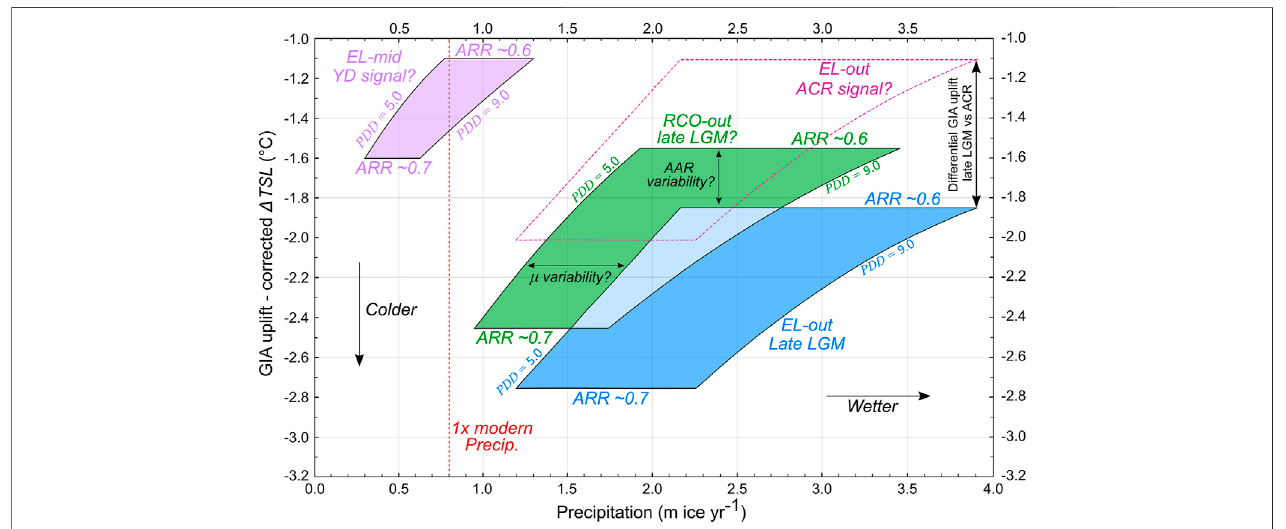
FIGURE 9 | Ice- fl ow model temperature depression and precipitation parameter combinations for moraine-matching simulations of the EL-out (blue), EL-mid (purple)and RCO-out(green)advances/still-stands. Temperature depressionvaluesarecorrectedformodelledGIA-related uplift since timeofadvance/still-stand. Note that GIA-corrected temperature depressions include the hypothetical assumptions that the EL-mid advance/still-stand dates to the YD ( ∼ 12 ka), and the RCO-out and EL-out advances are coeval ( ∼ 18 ka). The dashed purple “ SMB parameter box ” denotes a hypothetical advance/still-stand of the EL glacier reaching a similar ice- front position to the EL-out advance, but dating to the ACR ( ∼ 14 ka) and thus associated with less GIA-related uplift (17.7 m).